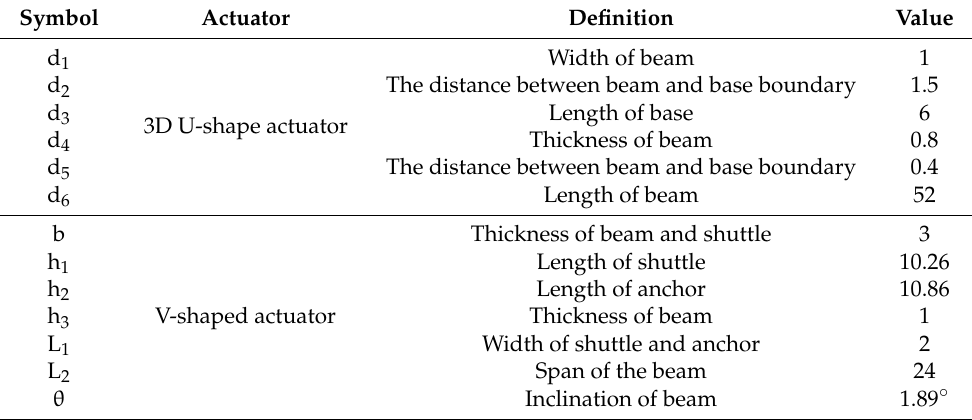
Table 1. Dimensions of the 3D Microgripper (Unit of Length: